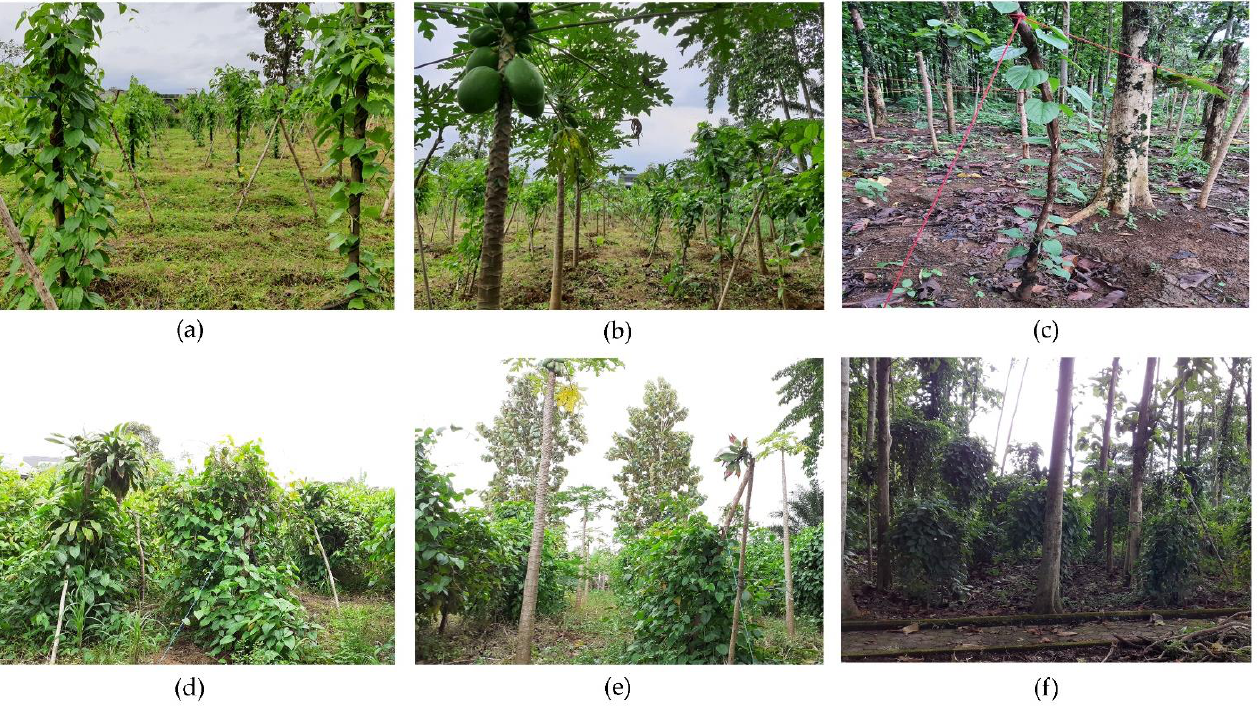
Figure 1. Sacha Inchi plants in experimental garden of Natural Product Laboratory, SEAMEO BIOTROP, Bogor. Growth performance of Sacha Inchi plants at the first month after planting ( a , b , c ) and six months after planting ( d , e , f ). Sacha Inchi plants in the open area ( a , d ), mixed culture ( b , e ), and agroforestry ( c , f ).